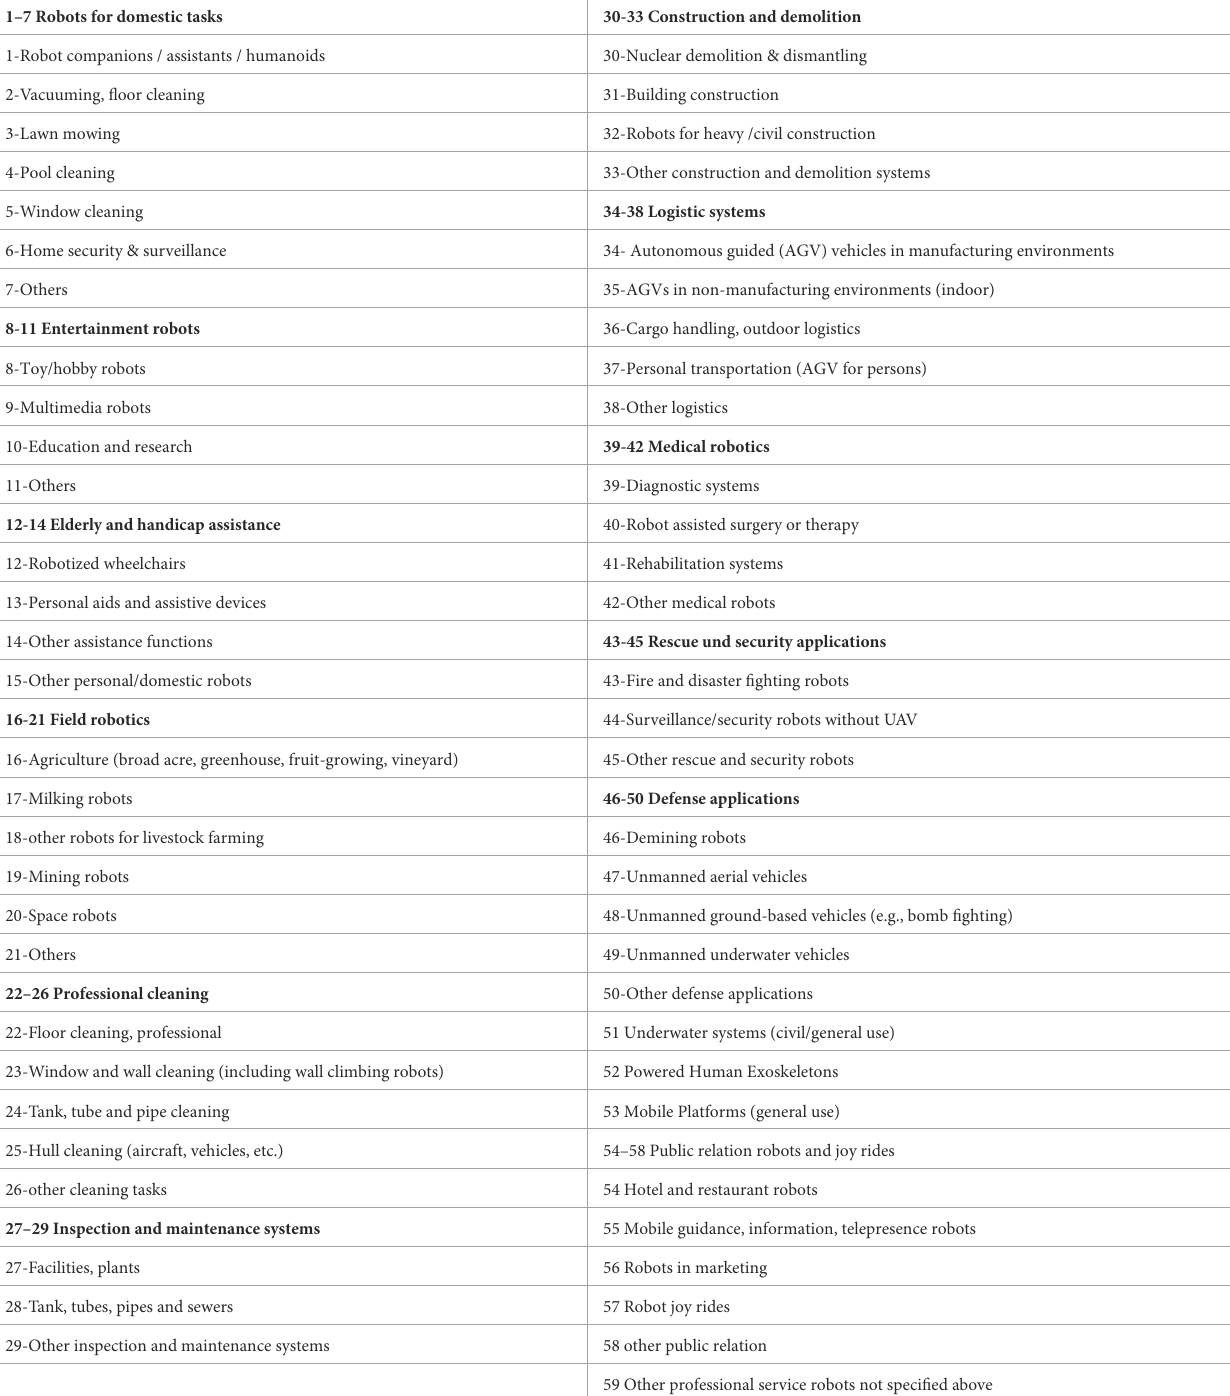
TABLE 3 Service robot classification according to IFR-UNECE